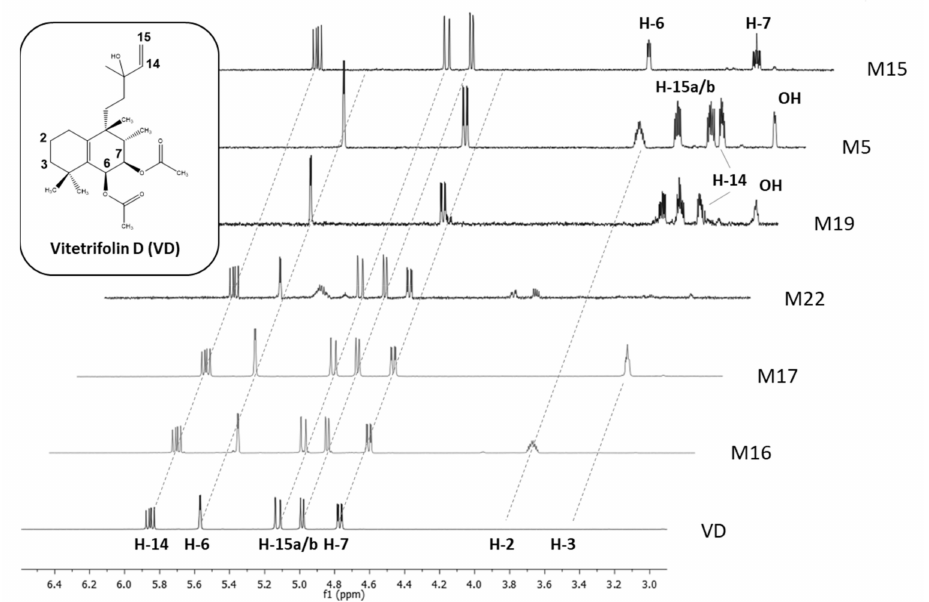
Figure 3. HPLC-SPE-NMR-recorded proton NMR spectra portion of vitetrifolin D (VD) and metabo- lites (600 MHz, solvent CD 3 CN), featuring signals of alkene protons and protons of hydroxylated alkane carbon centers. Inter-experimental shift value stability of structural features without changes in the chemical environment (e.g., vinyl group in VD, M15-M17, M22) allows for confirmation of its presence and understanding of its absence (M5, M19) as a structural change involving this structural